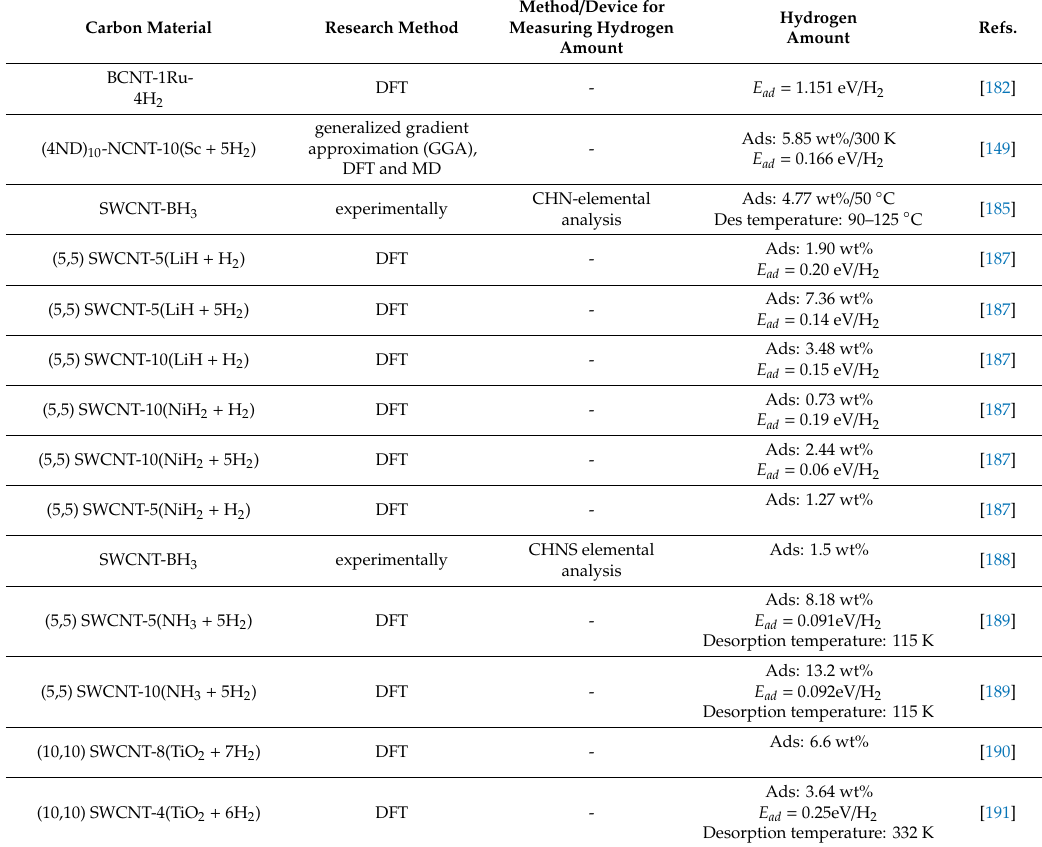
Table 4. Hydrogen storage properties of CNTs modified by other